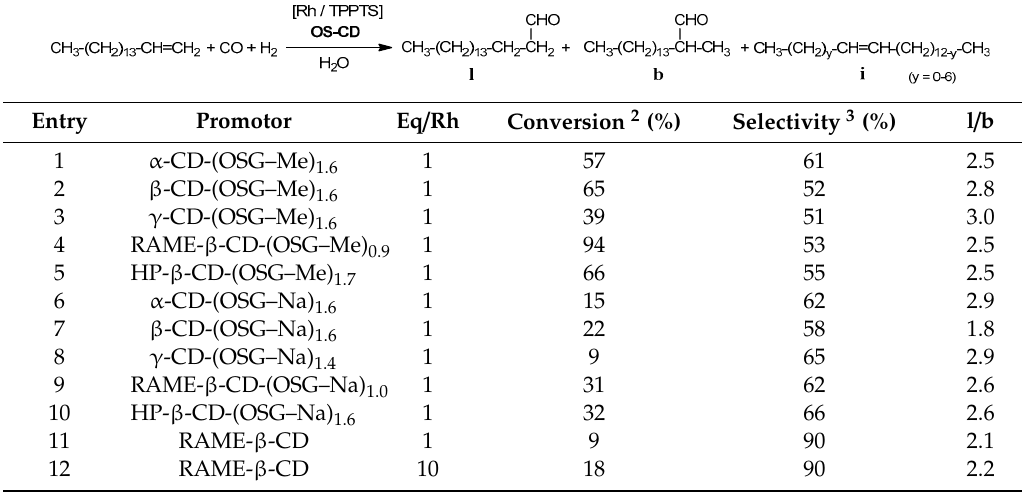
Table 3. Rhodium-catalyzed hydroformylation of 1-hexadecene in presence of various CDs. 1